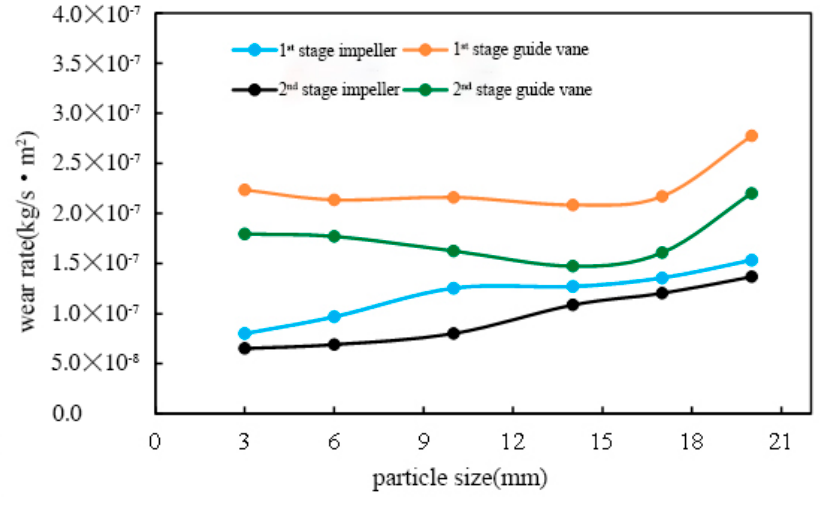
Figure 10. Changes in wear rate on the surface of through-passage components.